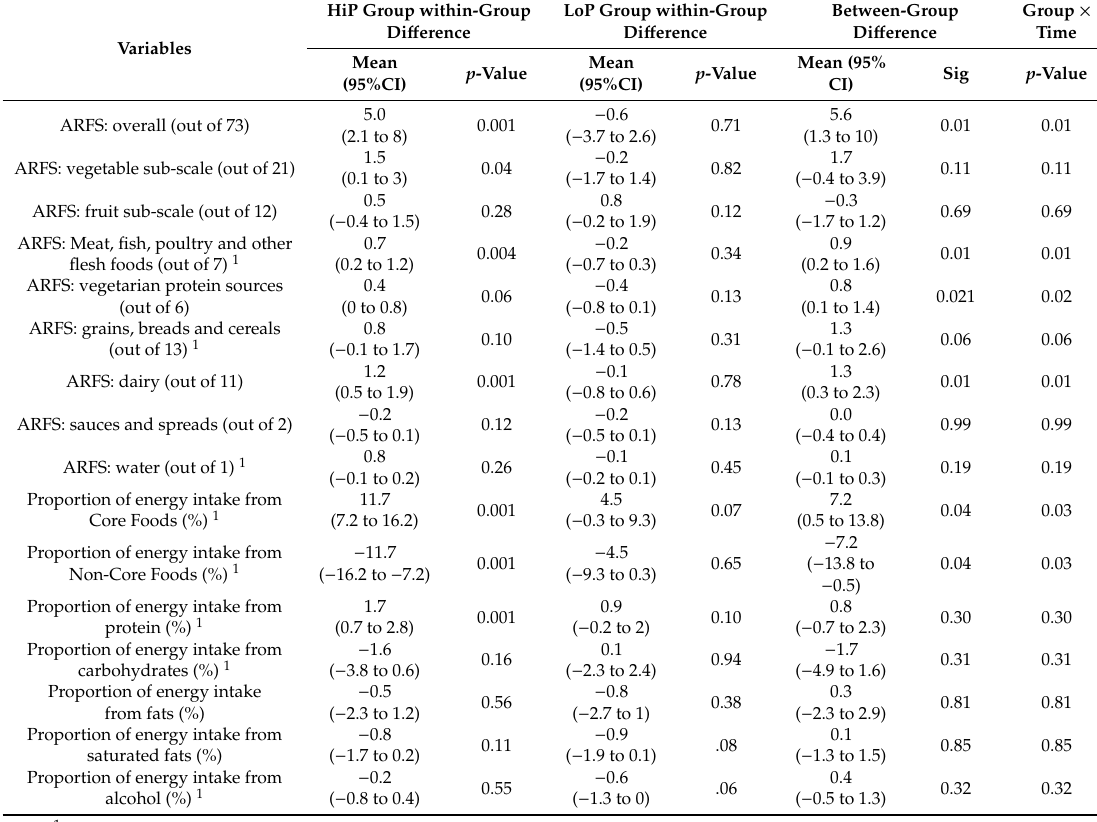
Table 3. Change in dietary